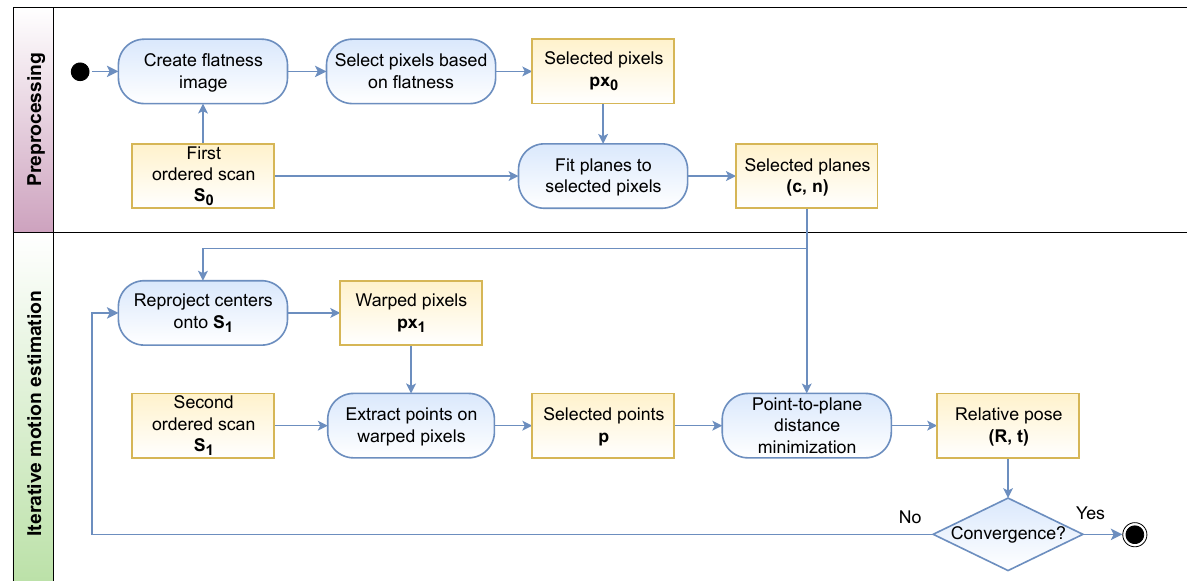
Figure 2. Overview graph showing the workflow of the proposed method. As a preprocessing step, a flatness image is computed from the first ordered scan S 0 to find the pixels most likely located in flat surfaces of the scene. Once planes have been fit to the selected pixels, the iterative motion estimation process can begin. It consists of reprojecting the selected planes onto S 1 based on the current motion estimation, which yields their corresponding pixel coordinates. From these image coordinates, the point related to the selected plane can be extracted, completing the feature pair <point, plane>. The relative pose estimation is then obtained by minimizing the point-to-plane distance of feature pairs. This is repeated until